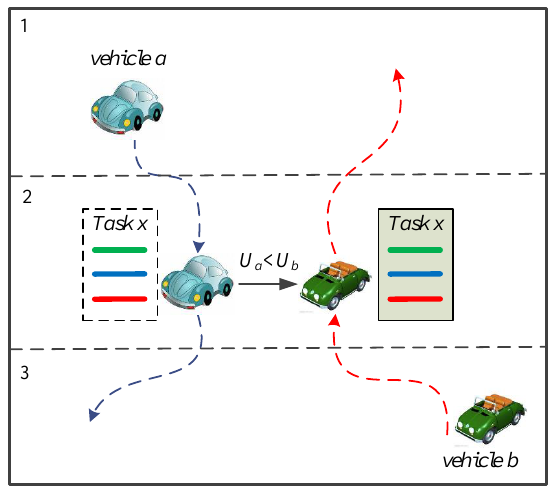
Figure 2. Sensing task